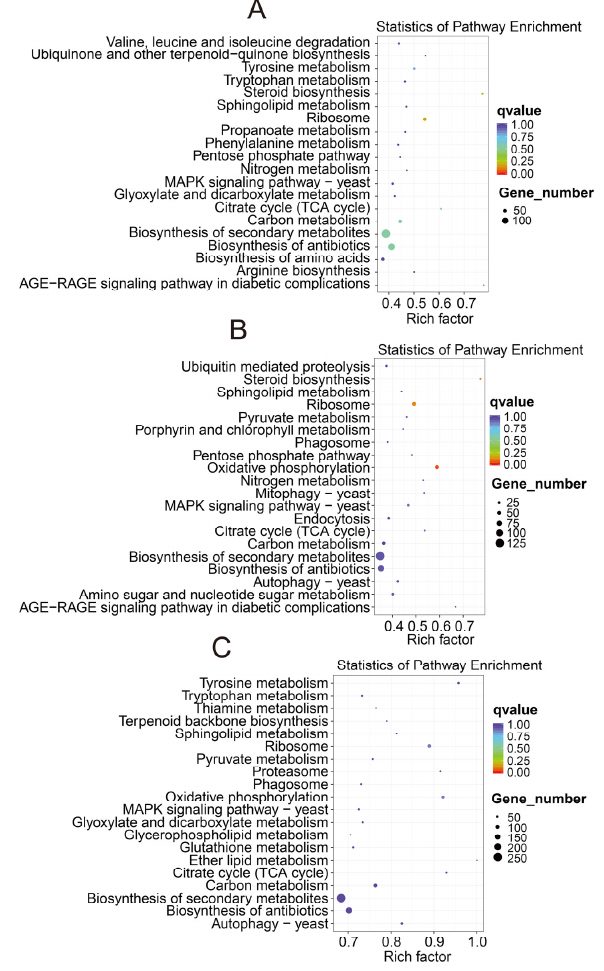
Figure 8. KEGG pathway analysis of differentially expressed genes in A. phaeospermum in three periods S2–S4. Note: Note: ( A ): S3 vs. S2; ( B ): S4 vs. S2; ( C ): S3 vs. S4. Note: The color of the dot represents different qvalues, and the size of the dot represents the number of differentially expressed genes in this pathway. In the differential analysis of the pathogen, it was found that the gene cutinase tran- scription factor closely related to the breakthrough of the host bamboo epidermis was heavily expressed in the S2 period. With the increase or decrease in the infection time, the expression of this gene was significantly reduced in the S3 infection period com- pared with the S2 period, while the S4 infection period was significantly reduced com- pared with the S3 period. It was analyzed that the pathogen was highly expressed in the S2 period just contacting the host hybrid bamboo epidermis to help the pathogen break